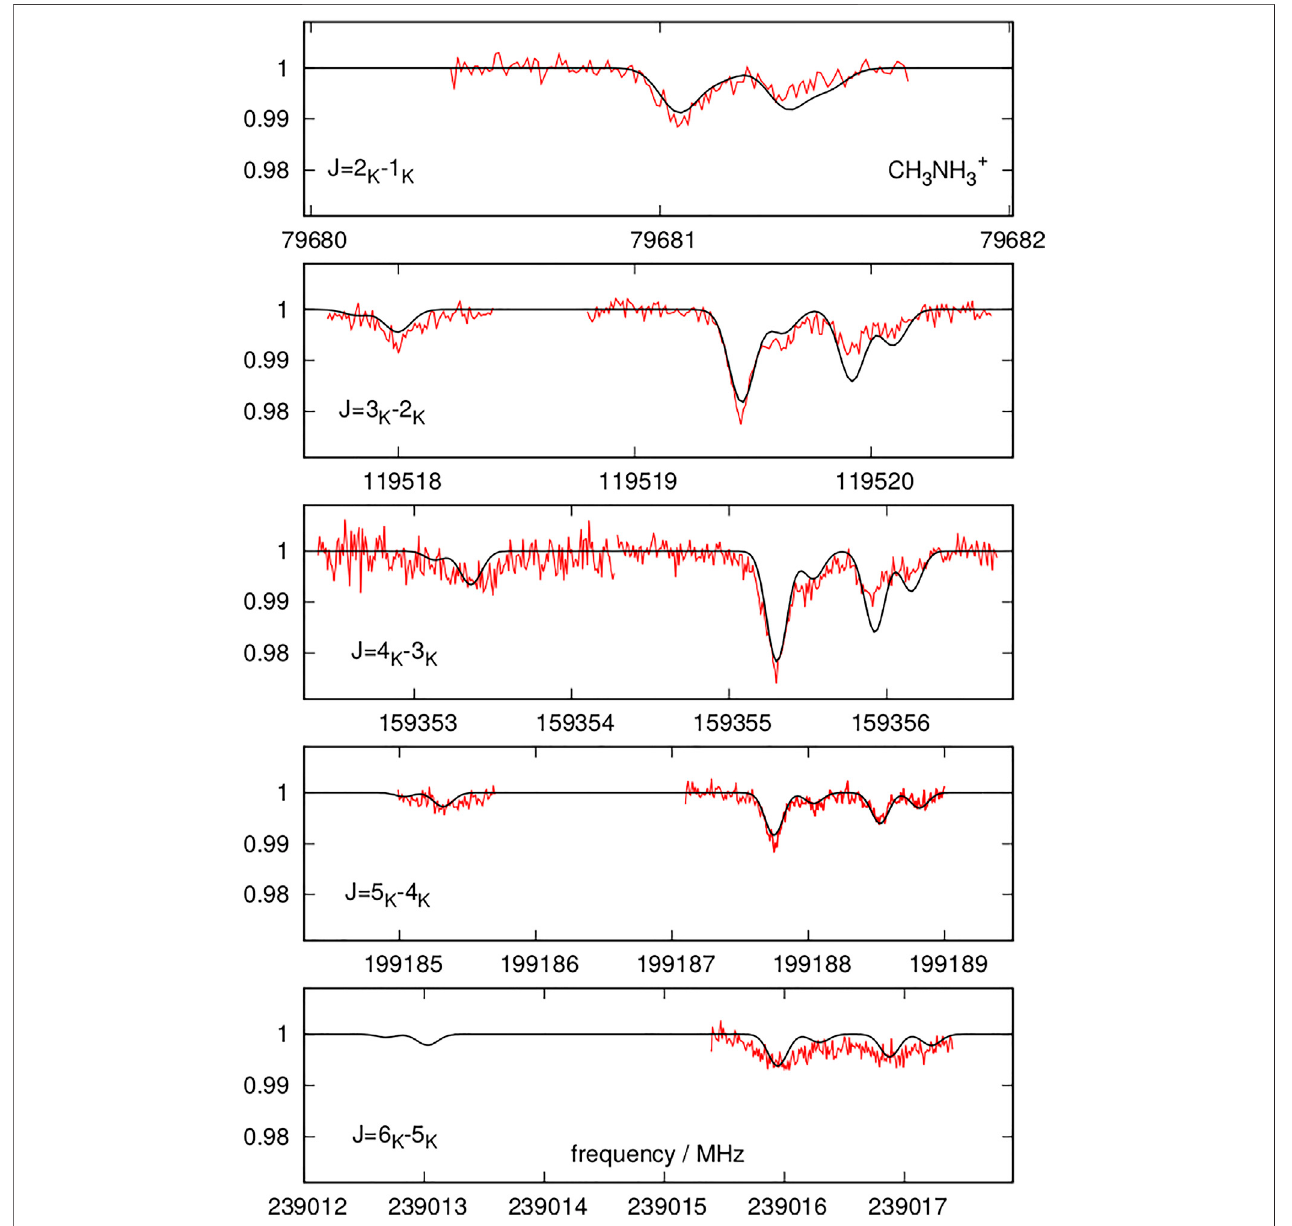
FIGURE 3 | Same as Figure 1 but with torsional splitting included into the simulation (black line, Table 1 , fi t II). Owing to the very small magnitude of eQq ( 14 N) calculated here, quadrupole hyper fi ne structure has not been considered in this simulation.